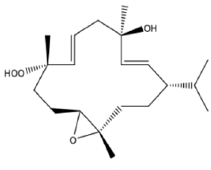
Figure 4. New cembranoid diterpene isolated from Sarcophyton sp. collected from the coastal waters Bohey Dulang, Sabah, Malaysia [32].